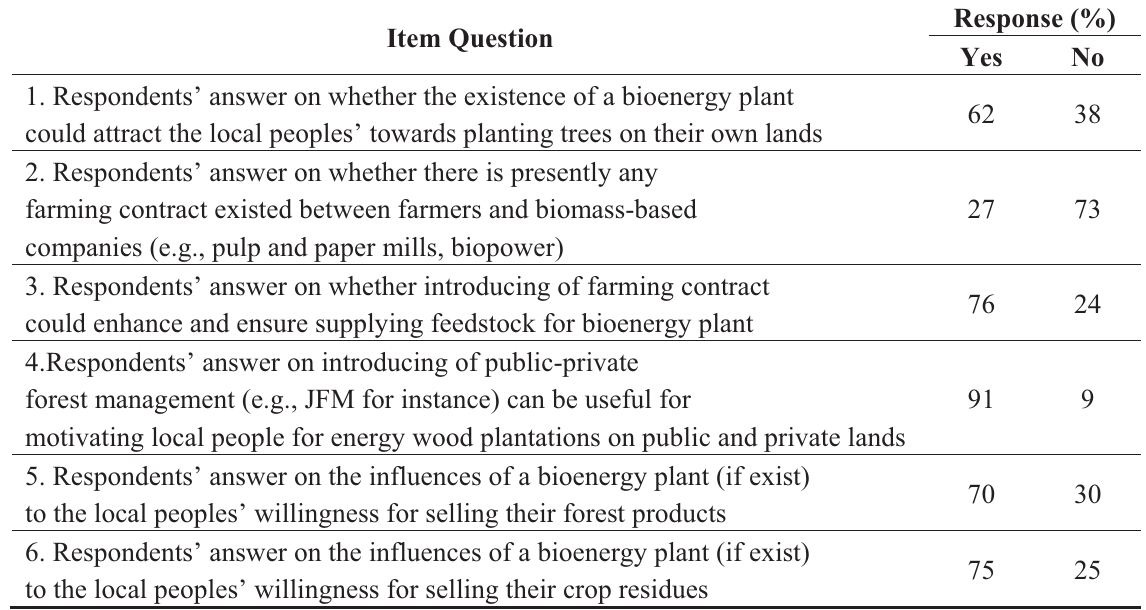
Table 7. Respondents’ views on local peoples’ attitudes towards bioenergy